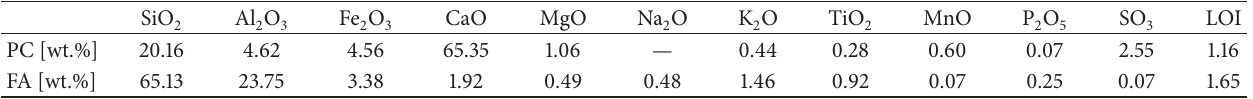
Table 1: Chemical properties of PC and FA by X-ray fluorescence method.